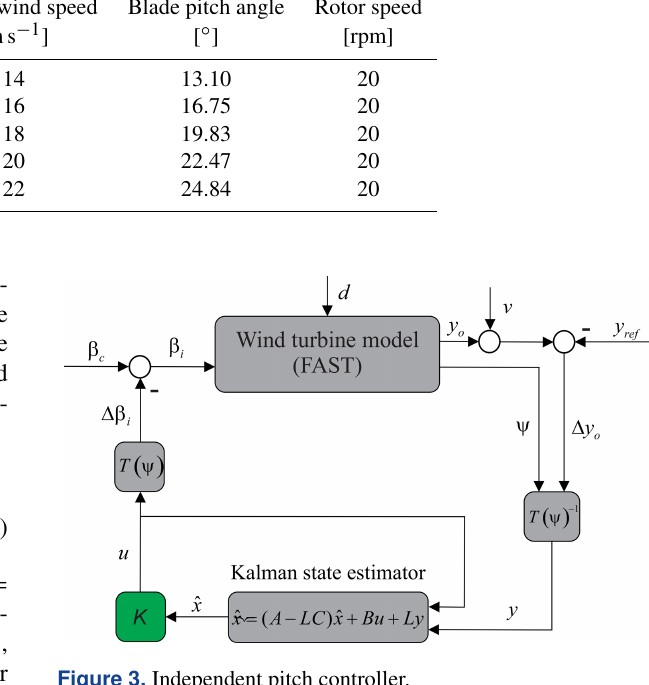
Figure 3. Independent pitch